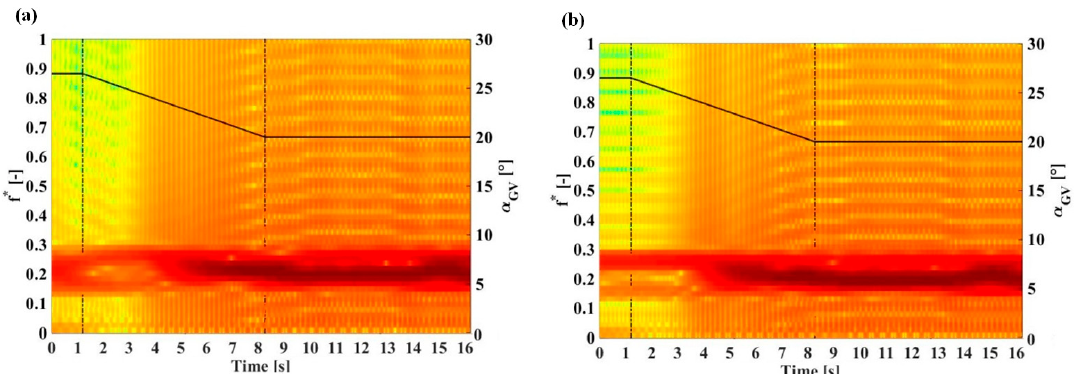
Figure 17. Spectrograms of the RVR plunging mode ( a ) and rotating mode ( b ). The black solid line represents the guide vanes angle with the y-scale to the right. The dotted vertical lines represent the start and the end of the guide vane closure. start and the end of the guide vane closure.